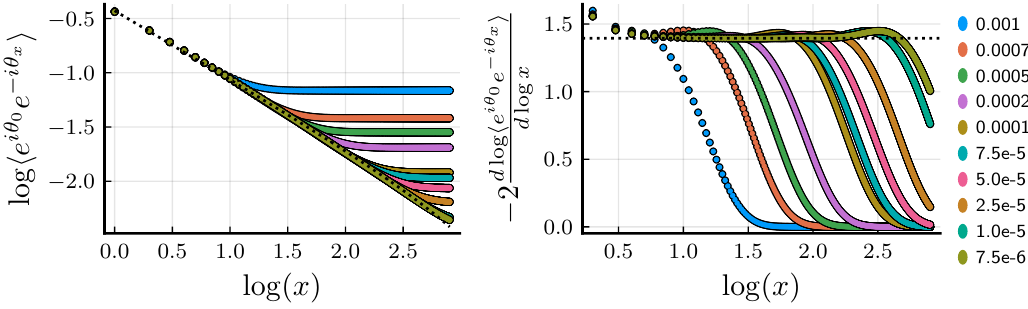
Figure 6 . (Left) The two-point correlator of the e iθ field at transition for the data point closest to the transition i.e. ( g 2 , g 2 ) ≈ (1 . 93 , 0 . 83) . The exponent for the fitted decay is K ≈ 1 . 257 consistent x y with all previous estimates. (Right) The logarithmic derivative of the two point function, using a finite difference estimator of the data in the left panel. For the larger bond dimensions we see a plateau spanning over roughly 80 sites; the value of this plateau coincides with K . In both figures the different colors correspond to decreasing values of the MPS truncation threshold, which are shown on the